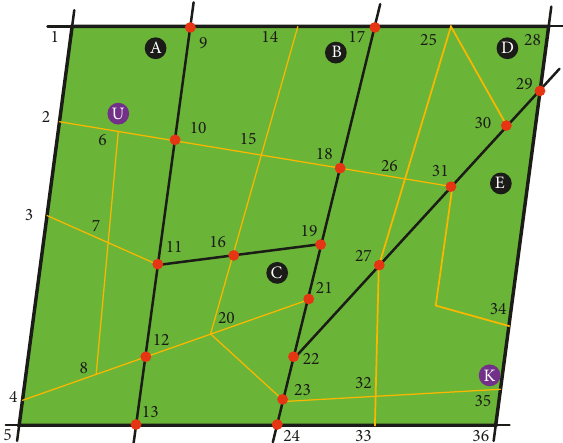
Figure 3: The schematic of a multi-region network with internal